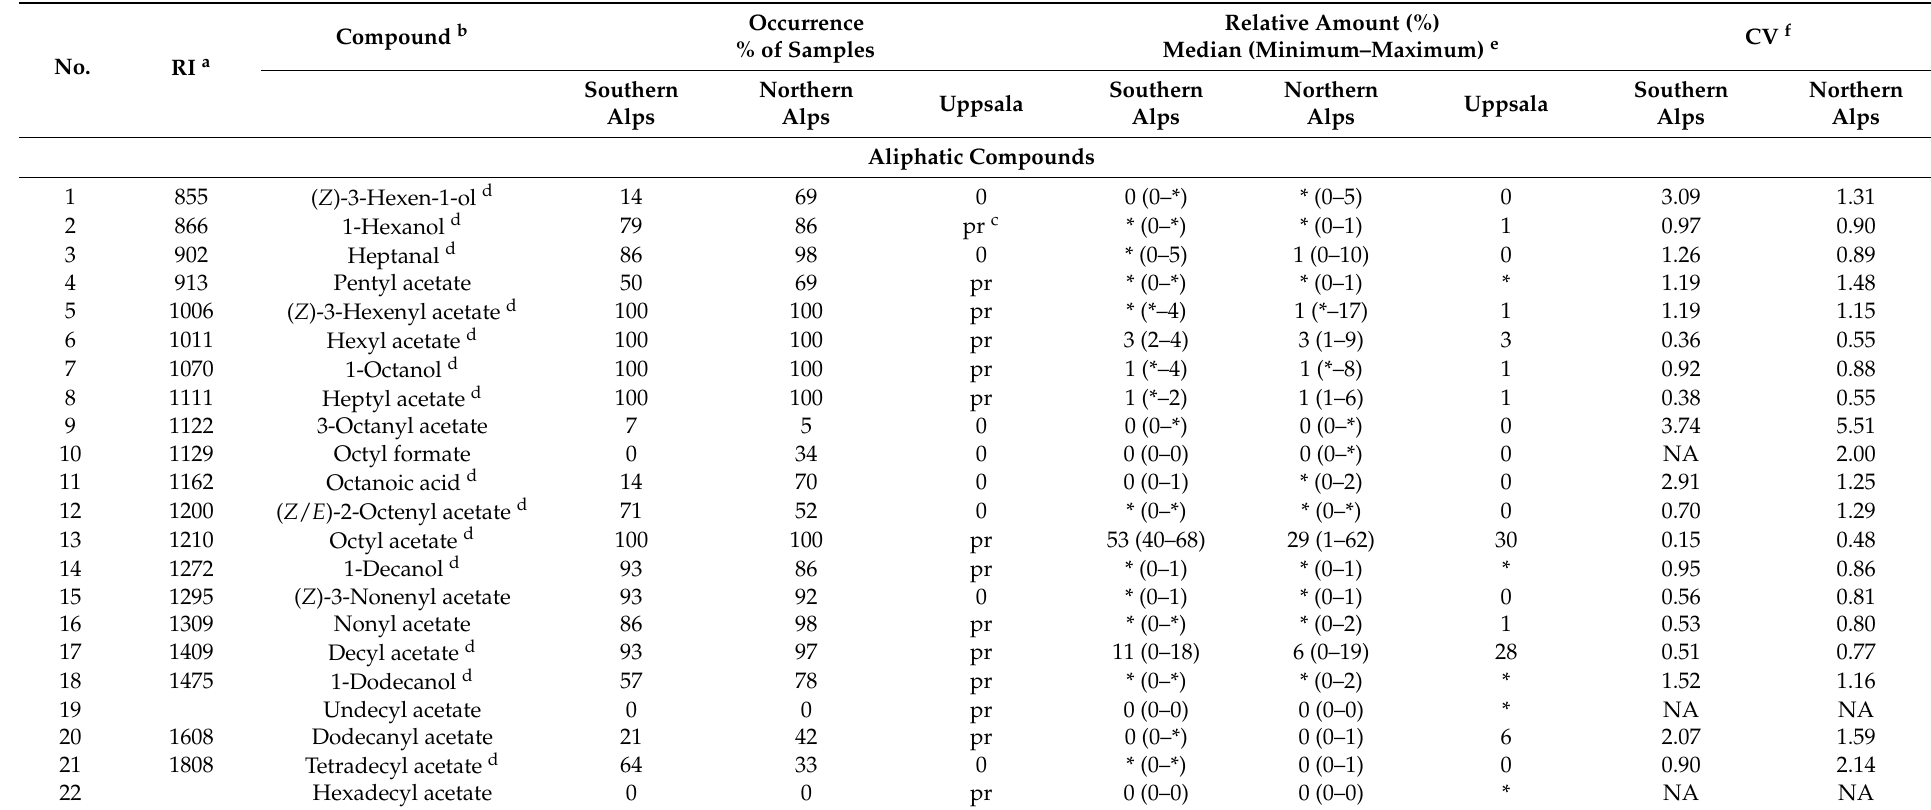
Table 1. Occurrence, relative and total absolute amount of scent, and coefficient of variation (CV) of compounds found in the scent of Cypripedium calceolus . Data are based on 78 flower scent samples in the Alps (Southern Alps: 14 samples; Northern Alps: 64 samples, 60 thereof from Braunschmid et al. [12]), complimented by mean values of 3 samples of Uppsala, Scandinavia (taken from Bergström et al.